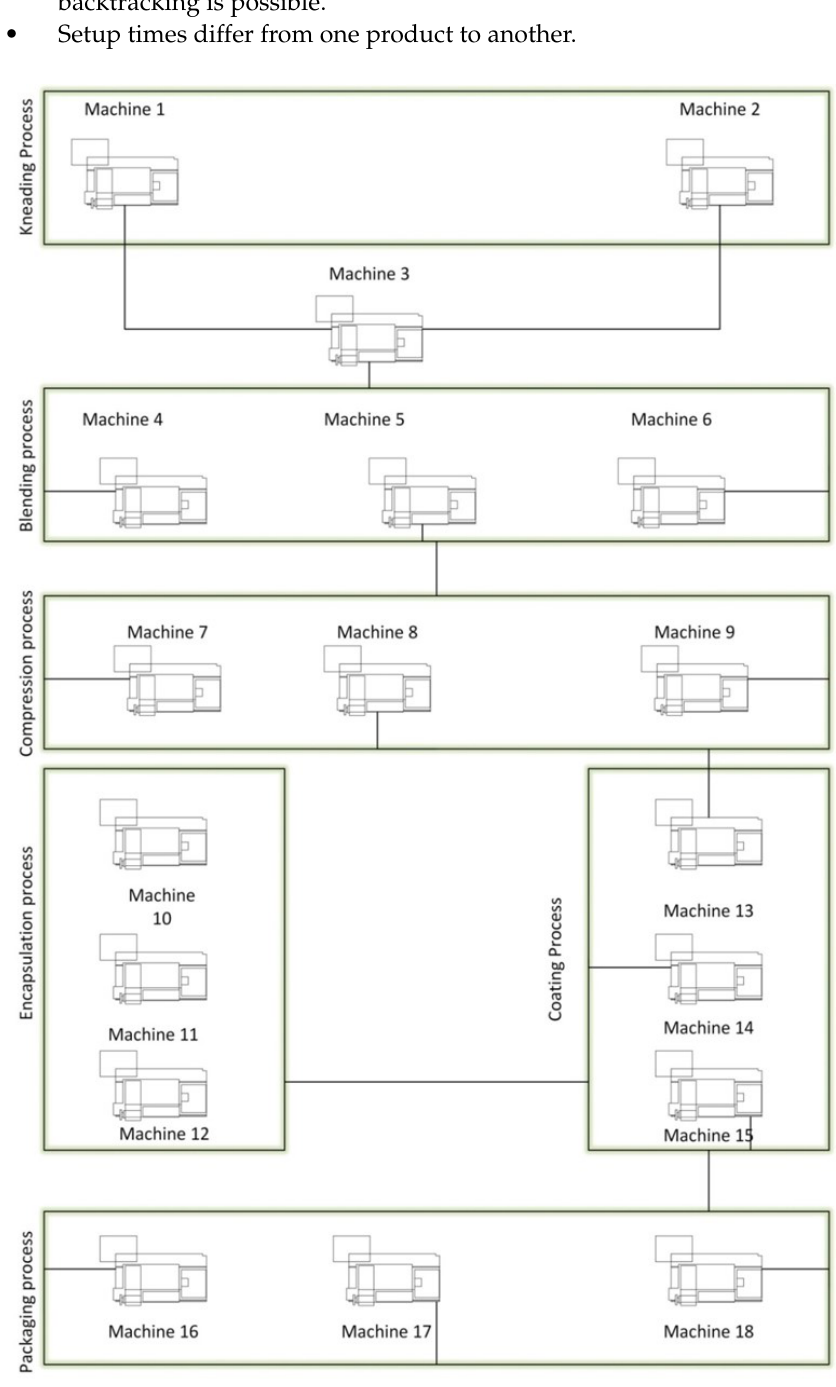
Figure 14. Shop floor layout for Factory X. The output of the DES simulation is a Gantt chart showing the routing of the products within the production line. The simulation is made multiple times for different dispatching rules EDD, SPT and LPT. The Gantt charts showing the products on the y-axis and the time at which these products are produced on the x-axis is shown in Figure 15. For each product, the sequence of machines for which the product passed on is shown. For